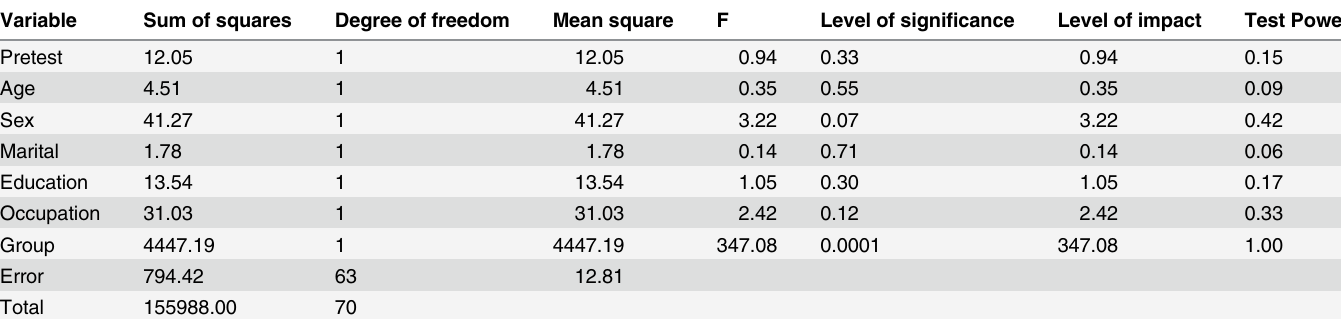
Table 6. The Mean Scores of Pretest and Posttest of Adherence to Self-Care Behaviors in Study Groups, Based on ANCOVA